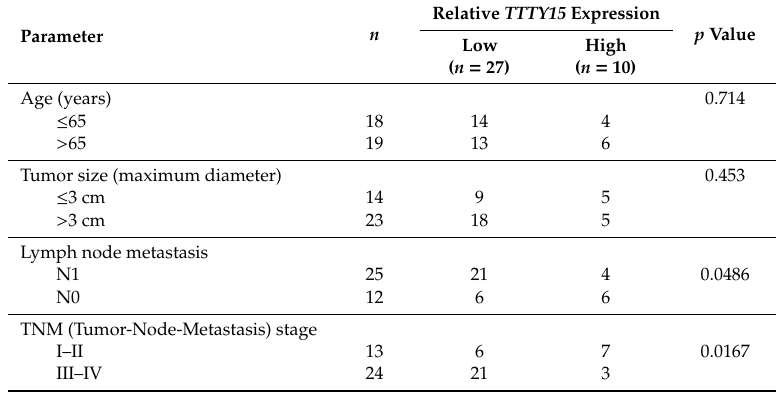
Figure 1. Relative expression and clinical significance of testis-specific transcript Y-linked 15 ( TTTY15 ) in non-small cell lung cancer (NSCLC). ( A ) TTTY15 was found to be downregulated in human NSCLC compared to the adjacent normal tissue (left). The paired data for the TTTY15 expression in tumor and normal tissue is shown on the right ( n = 37 for each group). ( B ) The relative expression levels of TTTY15 in NSCLC cell lines were validated by quantitative reverse-transcription PCR (qRT-PCR). ( C ) The efficiency of the TTTY15 knockdown in A549 and H441 cells was determined by qRT-PCR. Statistical analysis was based on Student’s t -test ( n = 3); *** p < 0.001. Table 1. TTTY15 expression and clinical characteristics of NSCLC patients ( n = 37).